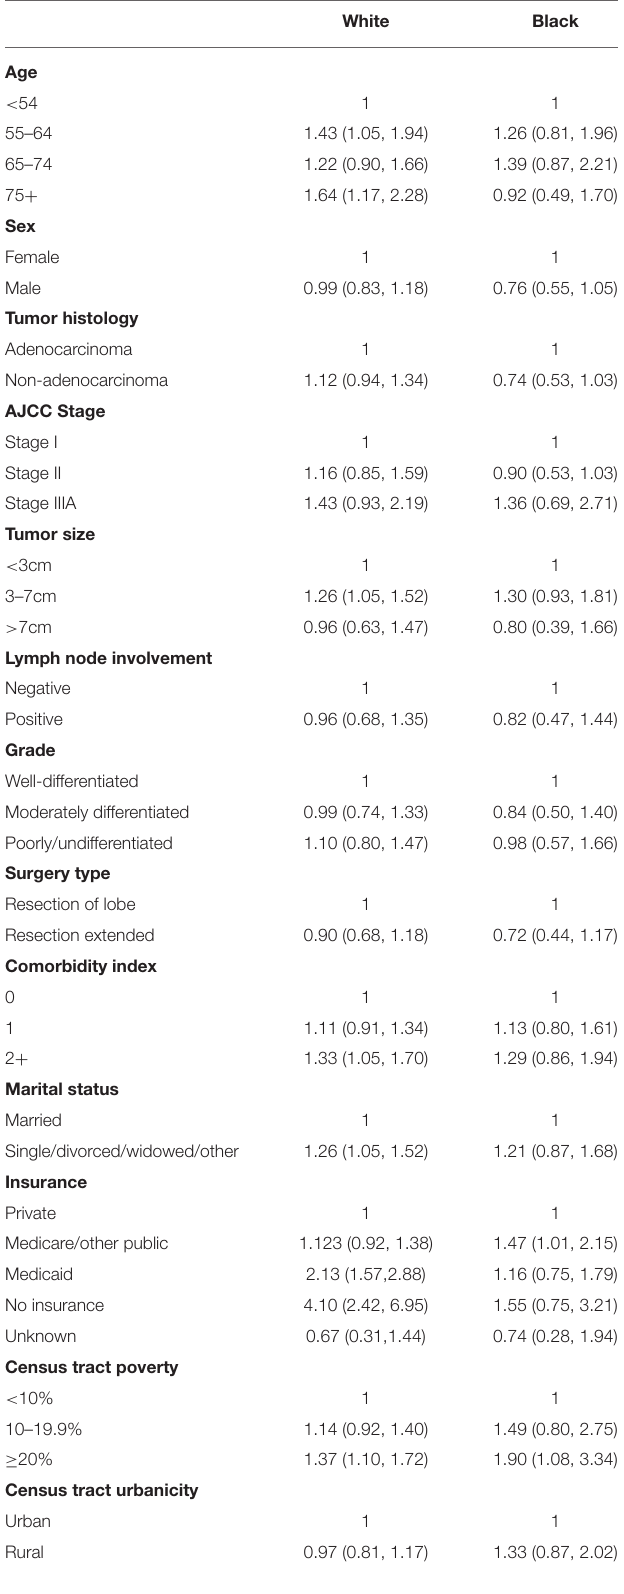
TABLE 3 | Adjusted odds ratios (95% confidence interval) of receiving surgery 6 weeks or later after non-small cell lung cancer diagnosis, stratified by